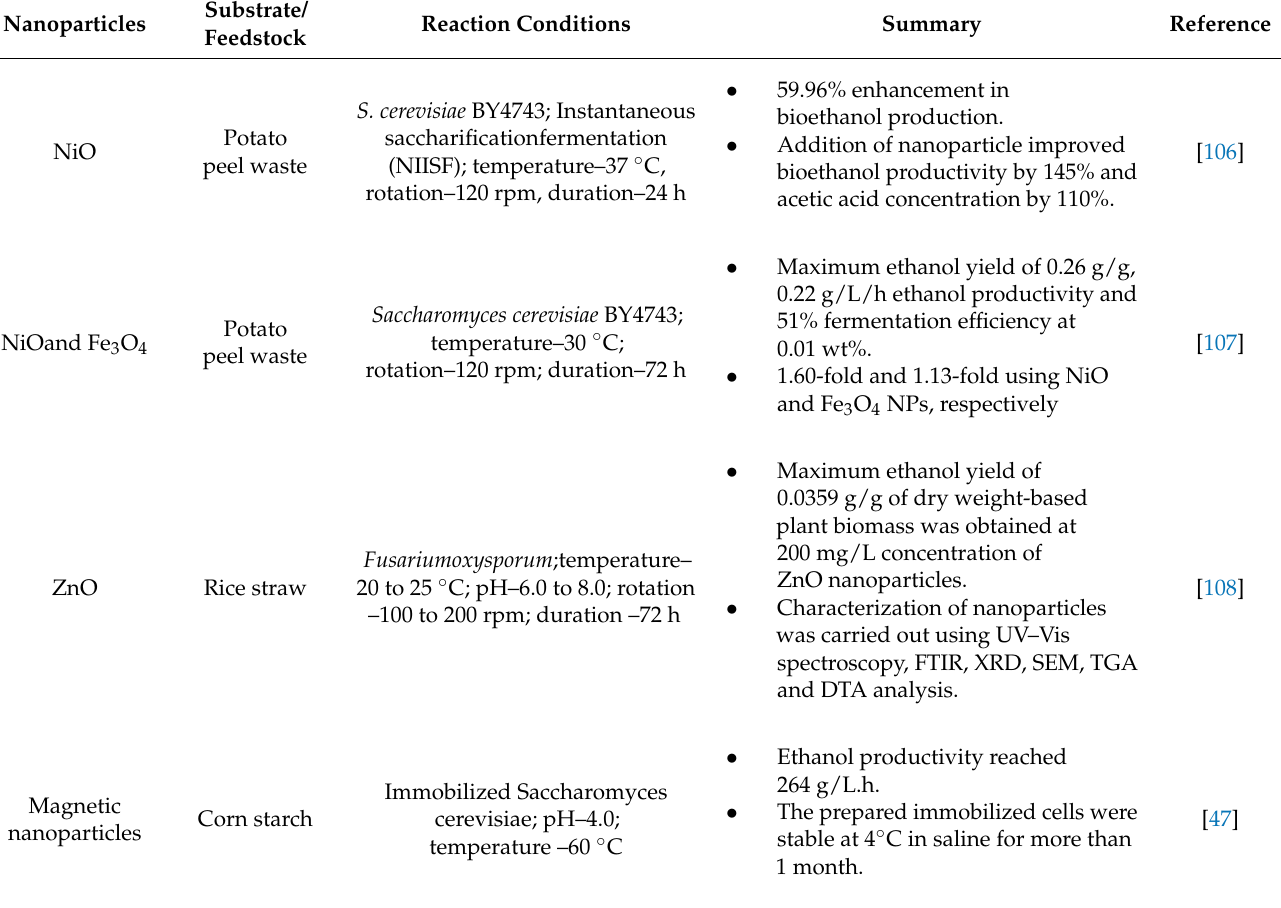
Table 3. Summary of application of nanoparticles in bioethanol production